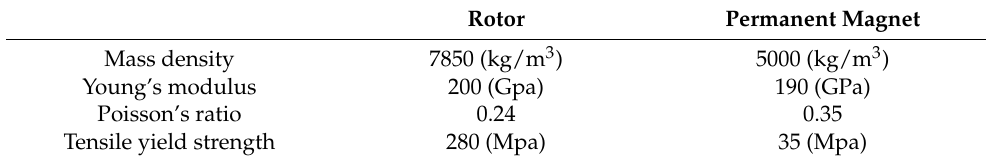
Table 7. Material property value.